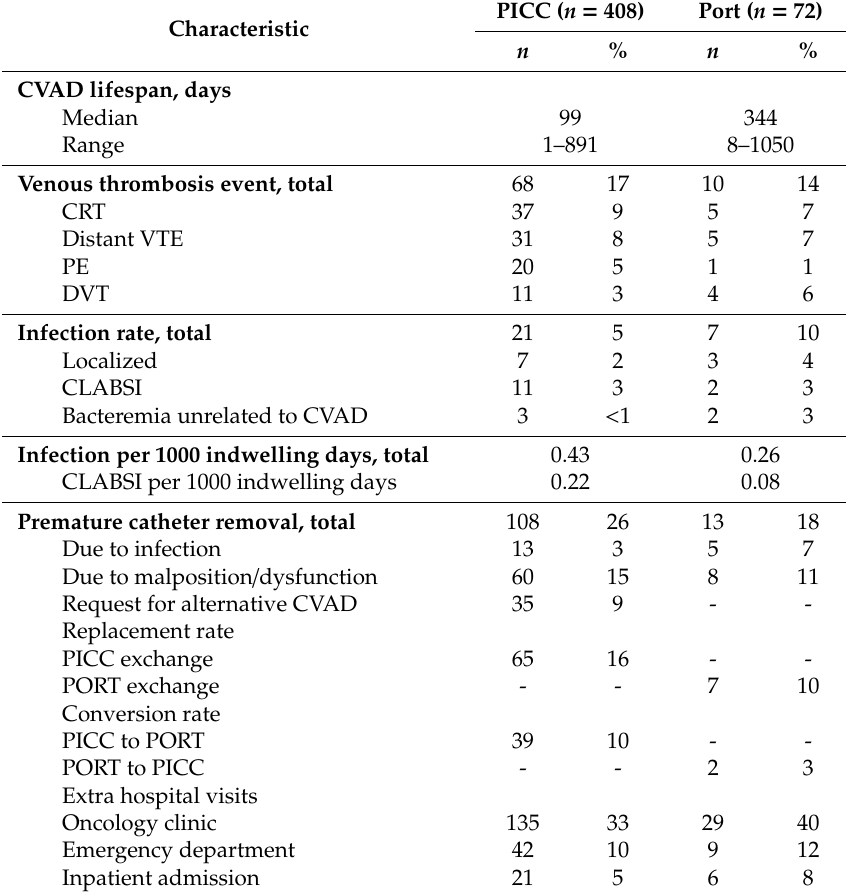
Table 3. Description of outcomes by CVAD